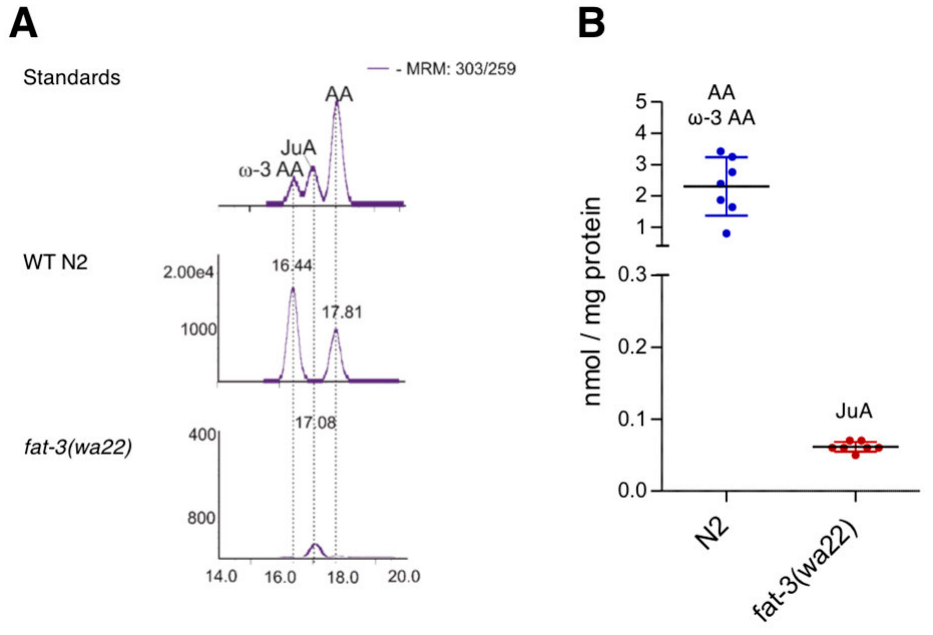
Figure 1. Detection and quantification of FAs in N2 (WT) and fat-3(wa22) C. elegans . ( A ) Chromatographic resolution in LC-MS/MS showing the presence of C20:4 FAs AA, ω -3 AA in N2 (WT) animals and new C20 FA JuA in fat-3(wa22) mutants. ( B ) Quantification of AA, ω -3 AA and JuA in wild type N2 and fat-3(wa22 ) mutants deficient in Δ 6 desaturase activity. Scatter plot shows mean ± SD.